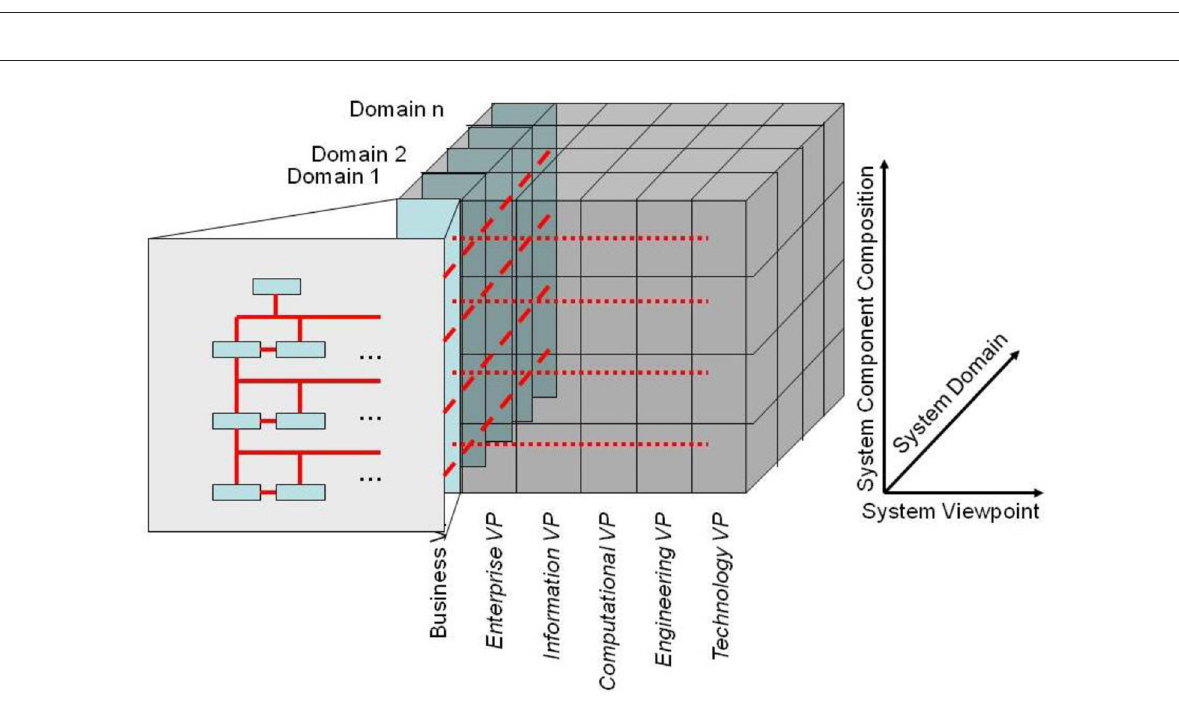
FIGURE20 The GCM model and